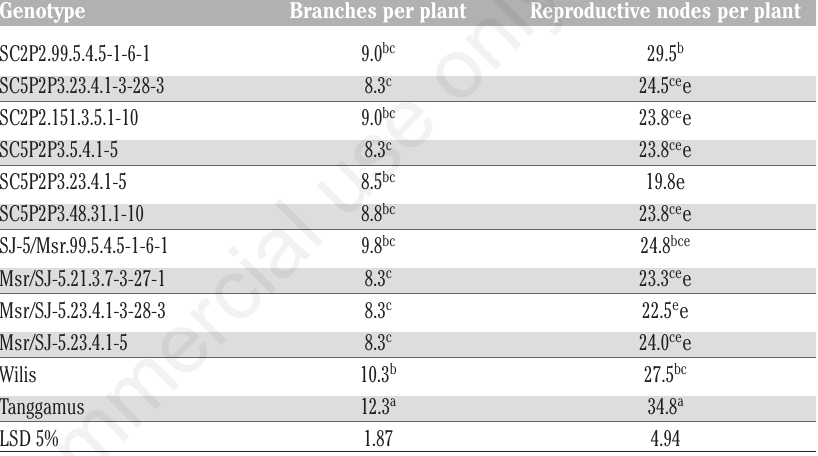
Table 2. Number of branches per plant, and number of reproductive nodes per plant of acid-adaptive soybean promising lines in Central Lampung, Indonesia. Genotype